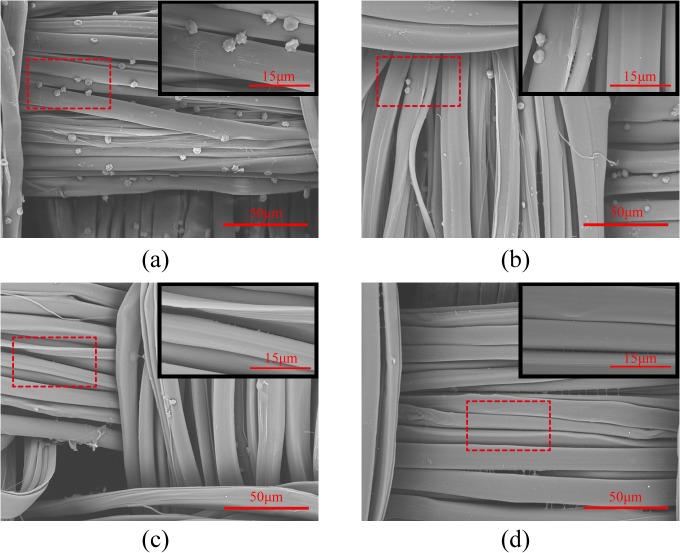
SEM photomicrographs of SF fabric and self-assembled (ALG/RSF)n SF fabrics after exposure to a PRP/PPP mixture solution.(a) SF fabric, (b) self-assembled (ALG/RSF)1.5 SF fabric, (c) self-assembled (ALG/RSF)5.5 SF fabric, and (d) self-assembled (ALG/RSF)9.5 SF fabric.